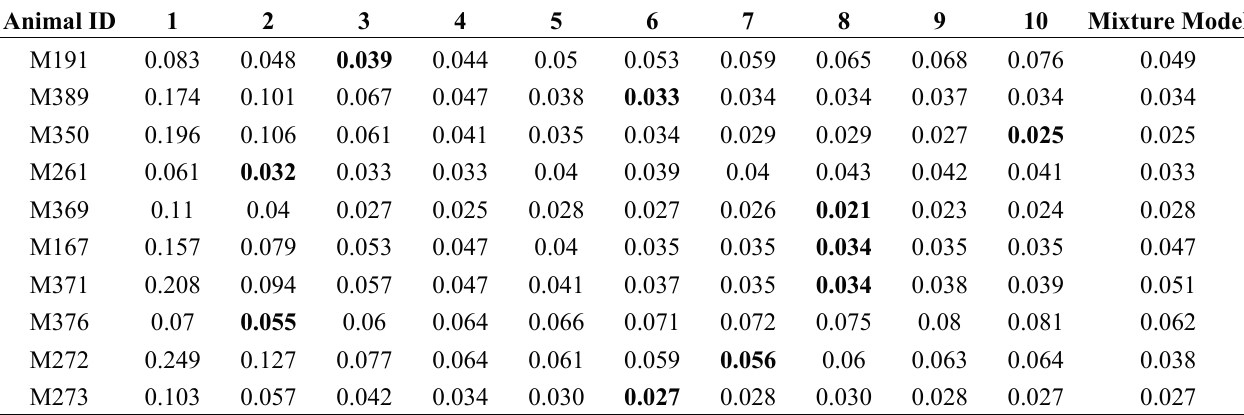
Table 1. The proportion of mismatched CrERV between two replicates for 10 animals. The data depict the number of mismatches at read count thresholds for 1–10 and for the mixture model. The read count threshold that minimizes the difference between replicates is in